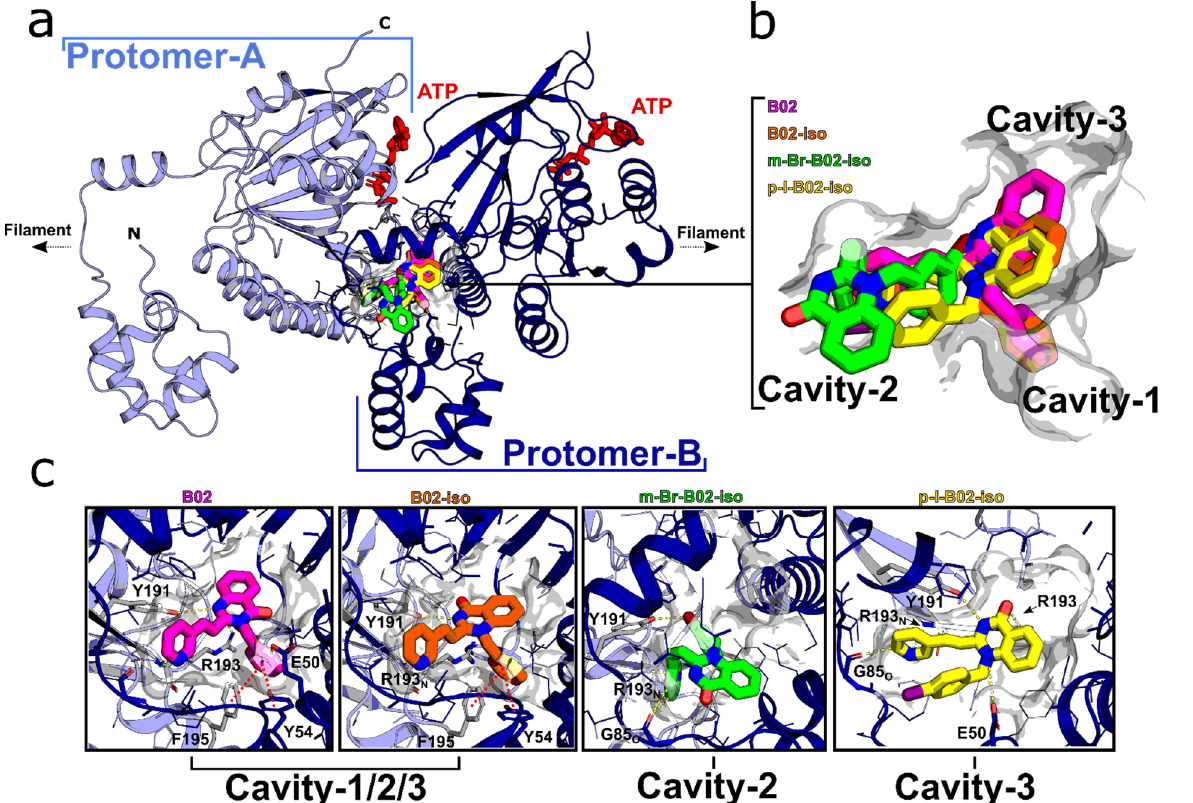
Figure 4. Docking of B02, B02-iso and B02-iso analogs to human RAD51 protein . ( a ) Dimeric unit of the RAD51-ATP filament (PDB code: 5NWL) and docked poses of B02 (pink), B02-iso (orange), m-Br-B02-iso (green) and p-I-B02-iso (yellow) within the protomer–protomer interface; ATP is shown in red. ( b ) Close-up view of the binding site with three distinct cavities, cavity-1, -2 and -3. ( c ) Molecular details of compound stabilization within the three cavities (shown in light gray surface); polar contacts are highlighted with yellow dashed lines, while putative π - π interactions (B02, B02-iso) are indicated with red dashed lines; an O- or N- in the index of a residue highlights the contribution of a mainchain carbonyl or nitrogen atom for the interaction, respectively; residues contributing polar contacts are highlighted with an increased stick radius in light blue/gray (Protomer A) or dark blue (Protomer B).